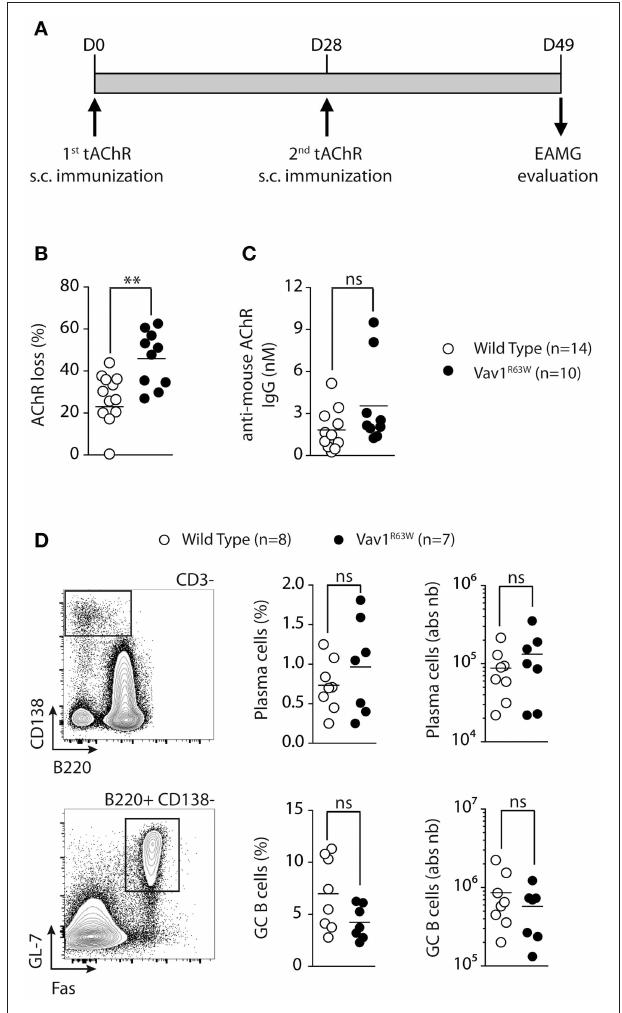
FIGURE 1 | The Vav1 R63W polymorphism increases EAMG severity. EAMG was induced wild-type (WT) or Vav1 R63W knock-in (Vav1 R63W ) mice by two immunizations with 10 µ g of torpedo AChR in CFA at d0 and d28 (A) . Twenty-one days after the second immunization, mice were killed for